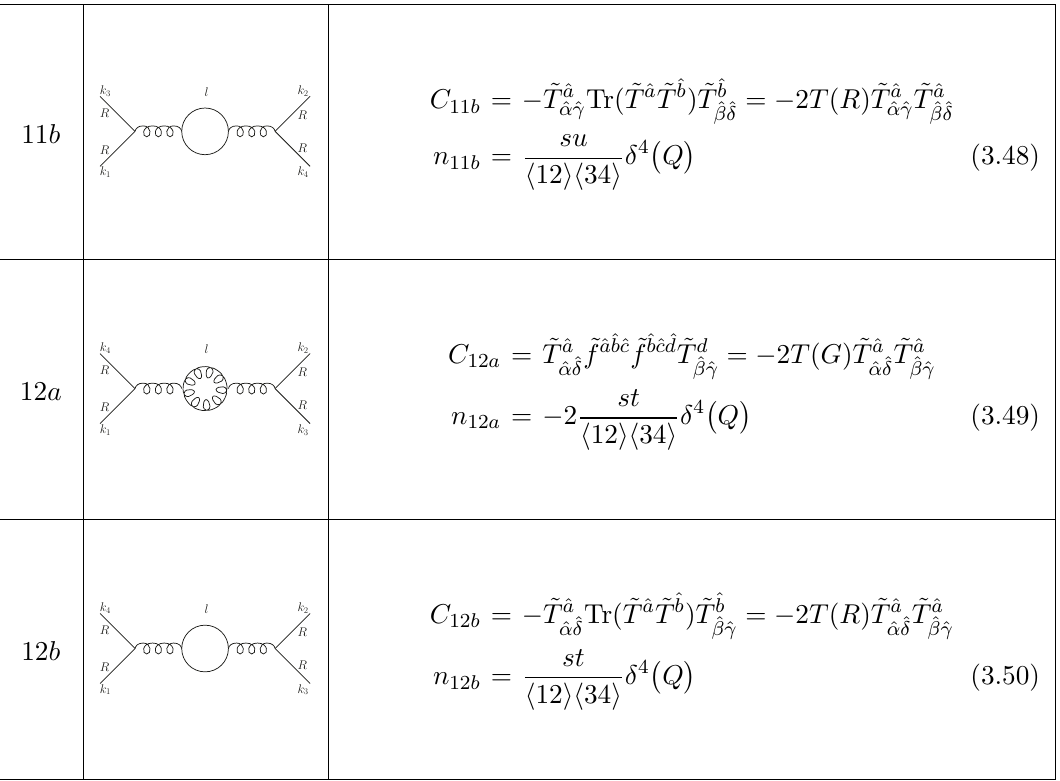
= ( T ^ a V (cid:0) 1 ) , ^ (cid:11) ^ (cid:12) ^ (cid:11) ^ (cid:12)